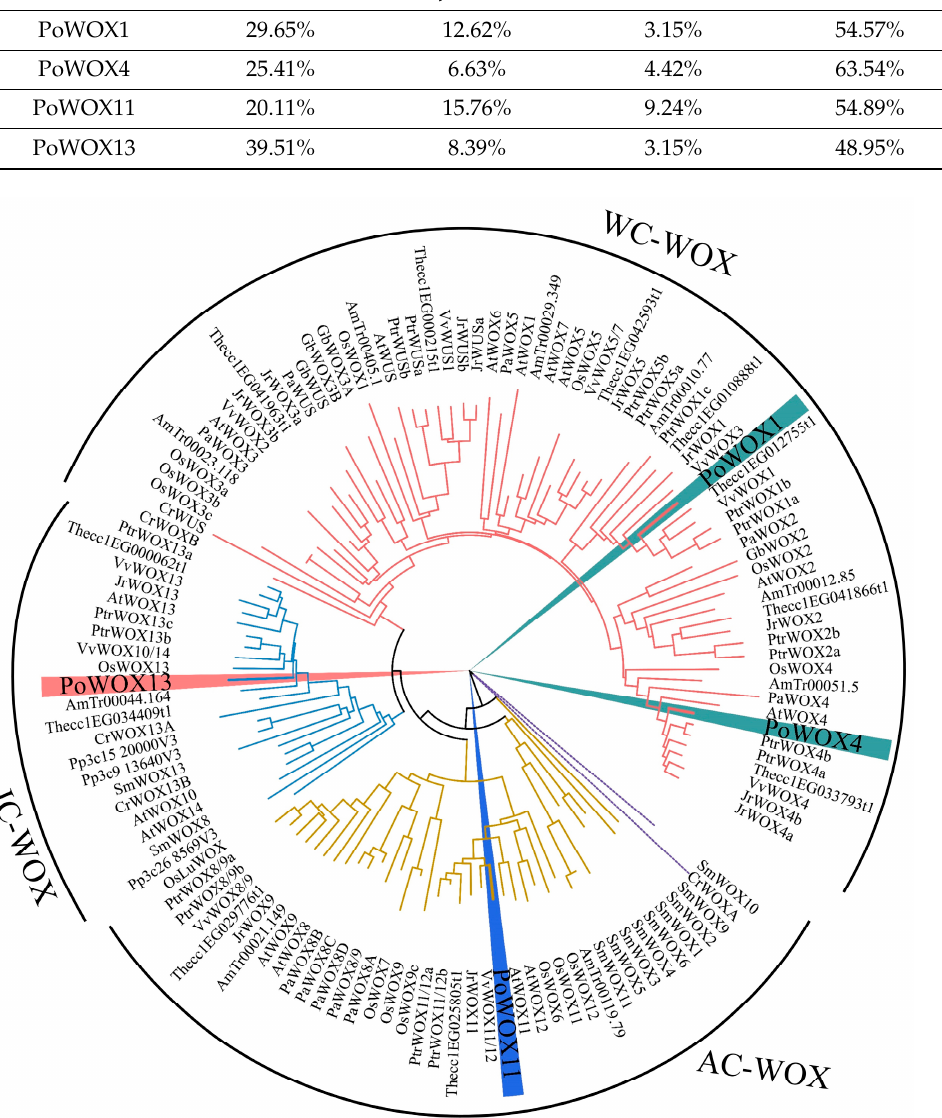
Figure 1. Phylogenetic analysis of WOX genes in plants. Evolutionary analysis of the full-length sequences of WOX proteins was performed by the NJ method using MEGA 7. A total of 127 WOX sequences from 14 species were classified into three clades: modern clade (WC-WOX), intermediate clade (IC-WOX), and ancient clade (AC-WOX). PoWOX1 and PoWOX4 were highlighted with green long triangular tags; PoWOX11 was highlighted with dark blue long triangular tags; PoWOX13 was highlighted with red long triangular